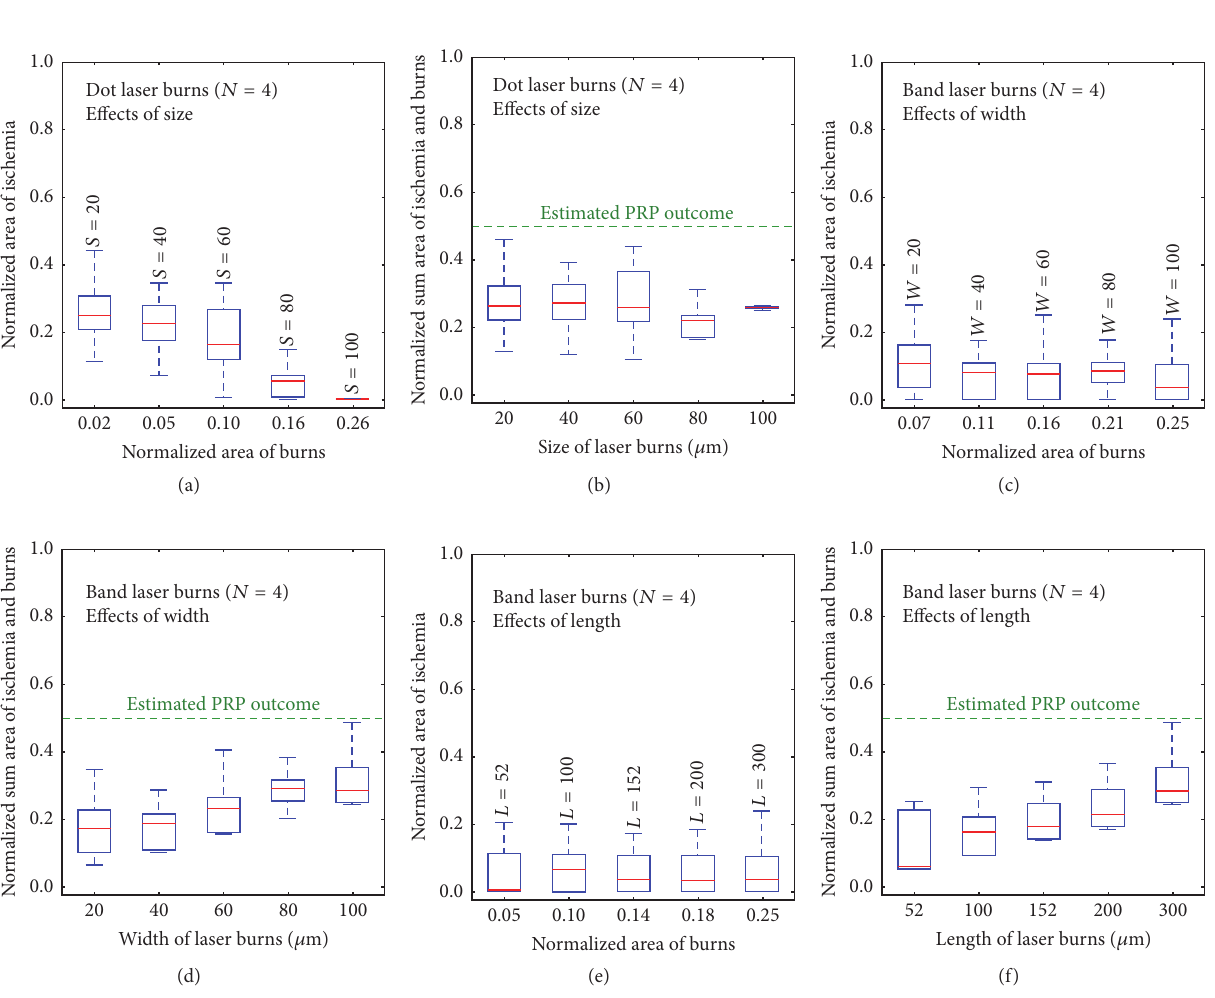
theoretically optimal placement of these small burns in the oxygen trough between the arterioles and